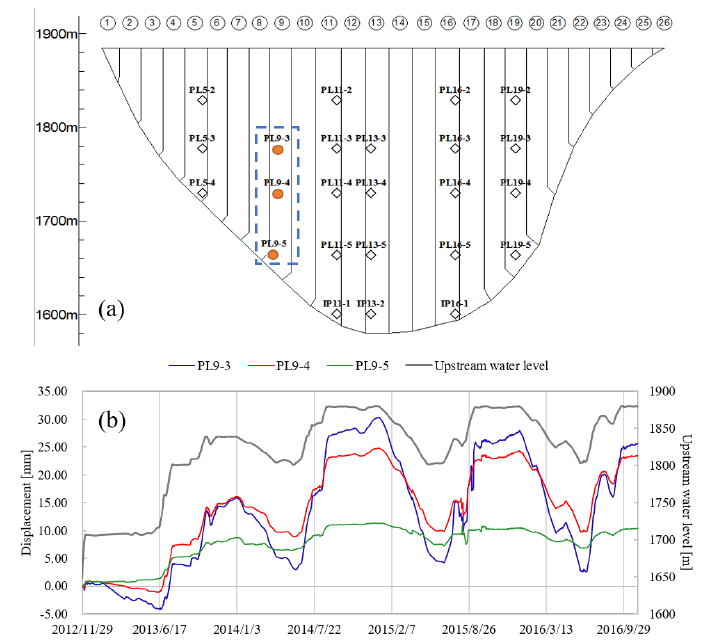
Figure 5. ( a ) Distribution of the monitoring points from upstream side view; ( b ) Time variation of radial monitored displacement data at the three selected monitoring points and upstream water level